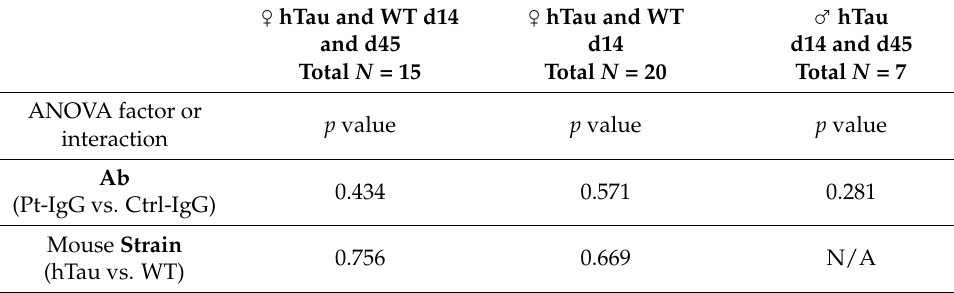
Table A2. Statistical analysis of sleep phenotype: time spent in